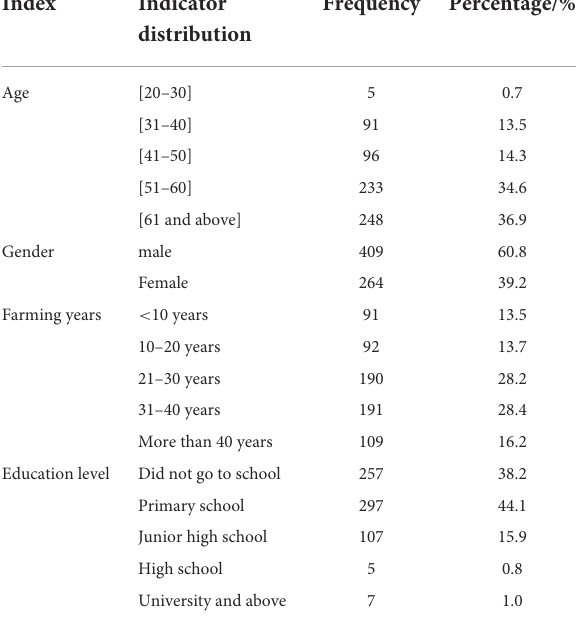
TABLE 1 Basic information